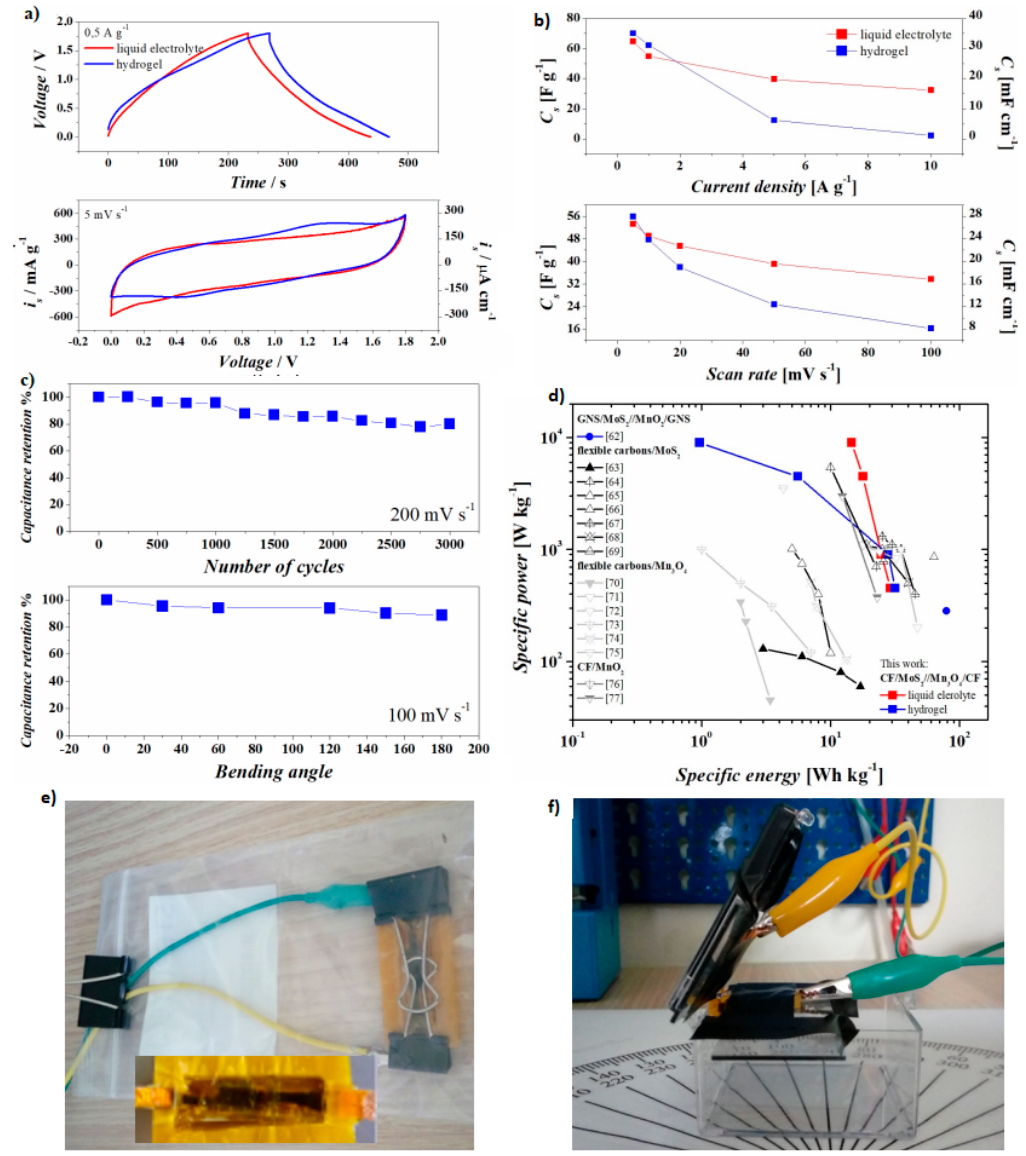
Figure 5. Electrochemical experiments on flexible devices employing liquid electrolytes (blue) and hydrogel (red): ( a ) charge and discharge at 0.5 A g − 1 (upper) and cyclic voltammetry at 5 mV s − 1 (lower), ( b ) specific capacitance estimated on charge and discharge experiments (upper) and on cyclic voltammetry (lower), ( c ) cyclability and bending stability, ( d ) Ragone plot and the pictures of the device with hydrogel during ageing (inset shows the device) ( e ) and bending ( f ) tests.